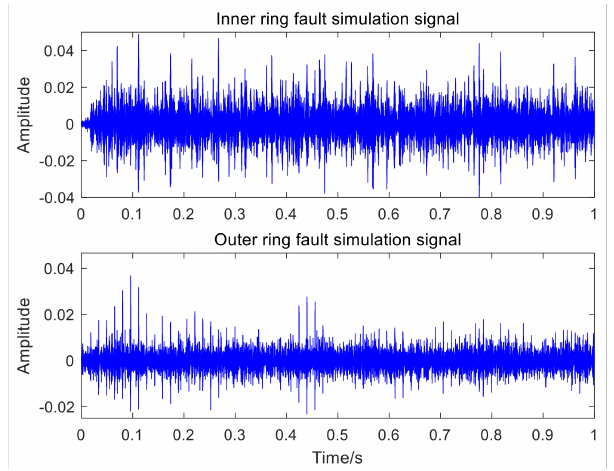
Figure 6. Time-domain waveform after MCKD